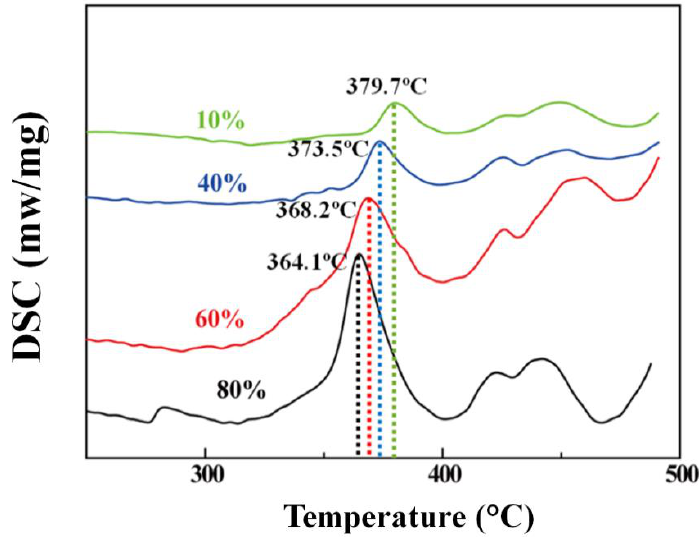
Figure 9. Sections ( φ = 0°) of ODFs on the pre-annealed samples after different cold rolling treatments.